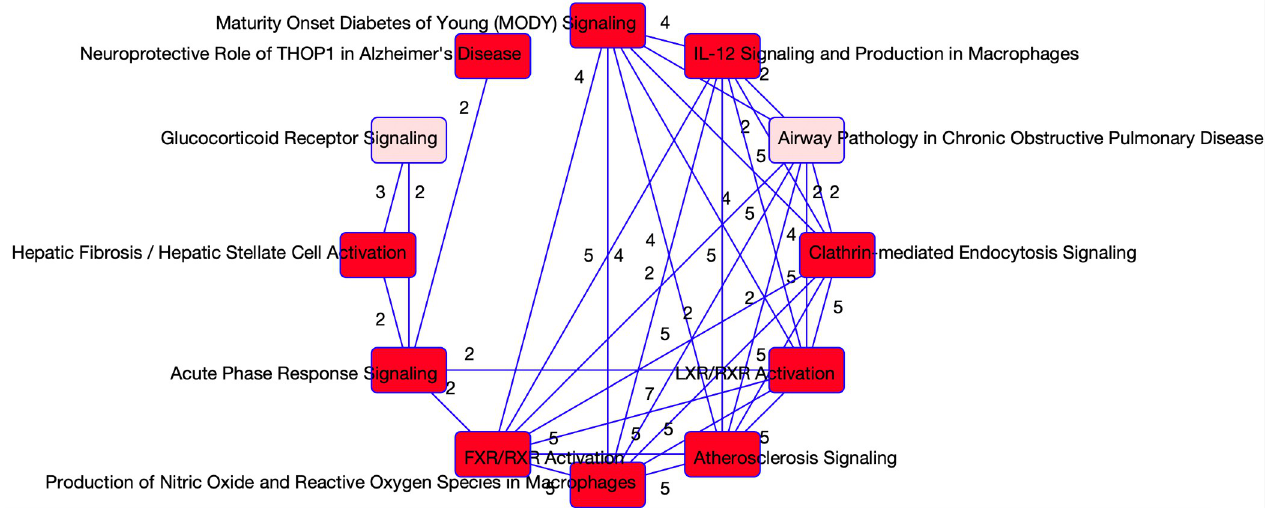
Fig 11. Overlapping networks associated with COVID-19. Visual of the overlapping networks enriched in COVID-19 as determined from the proteomics data. The nodes represent the networks and the edges represent the overlapping genes between the networks. The edge labels provide us with the number of overlapping molecules between the